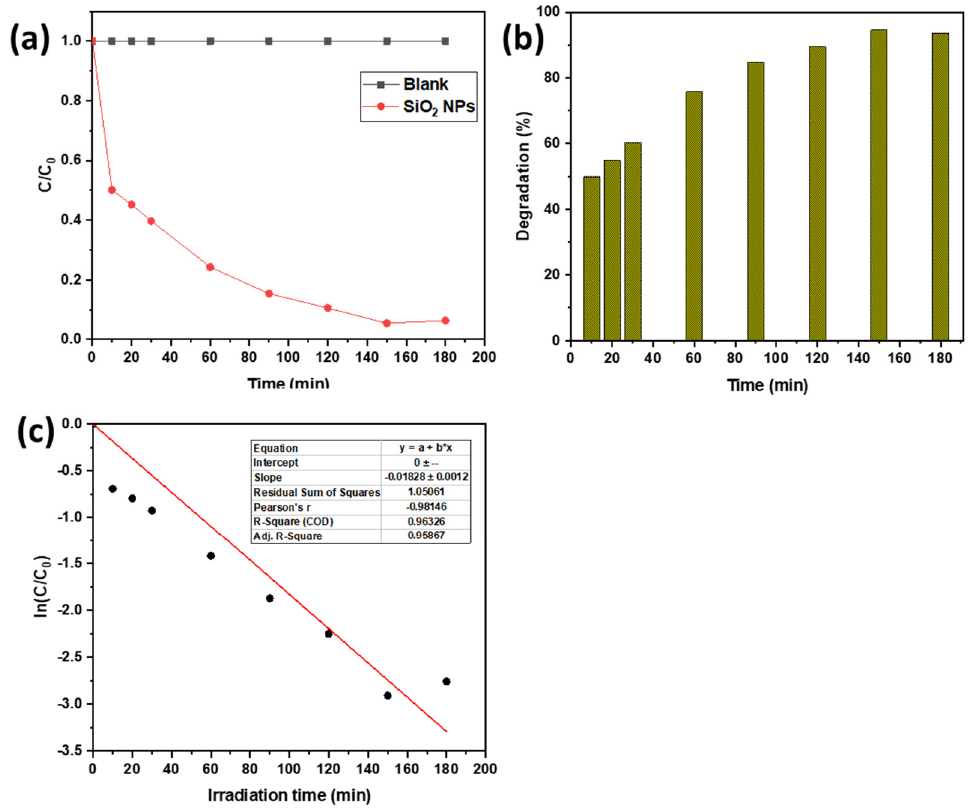
Figure 12. ( a ) Photocatalytic activity for the MO degradation using SiO 2 NP photocatalyst under UV light irradiation; ( b ) MO photodegradation rate on the surface of SiO 2 NPs, ( c ) the kinetic relationship of ln(C/C 0 ) vs. irradiation time curves.